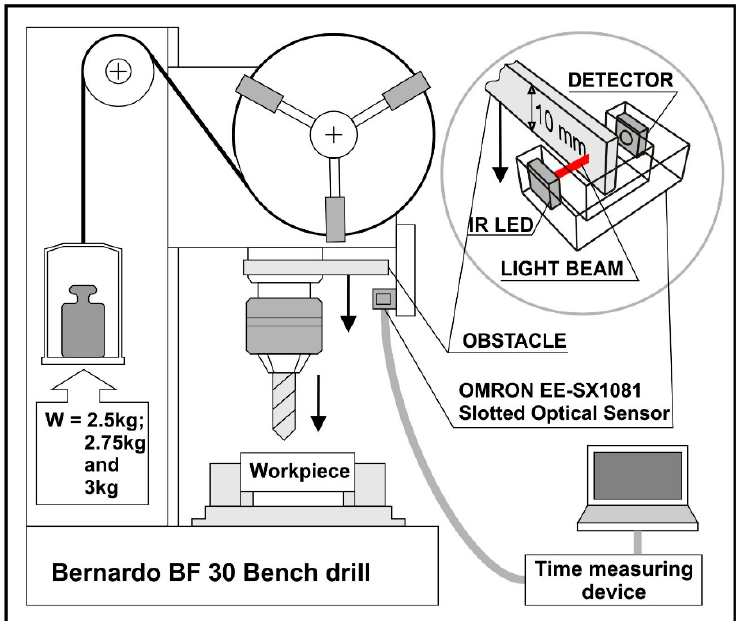
Figure 2. The scheme of the test stand used during the highly simplified machinability testing.